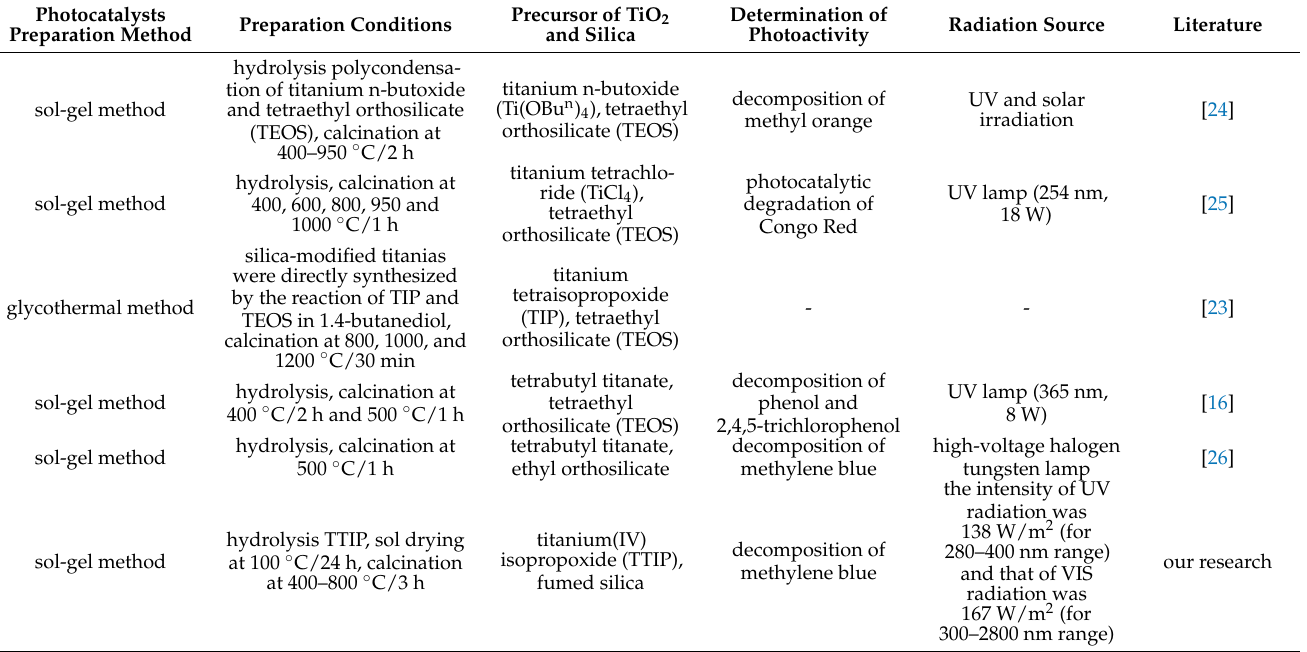
Figure 12. Schematic diagram of the preparation of SiO 2 /TiO 2 photocatalysts by sol-gel method. Table 6. Comparison of preparation methods for silica-modified TiO 2 photocatalysts.